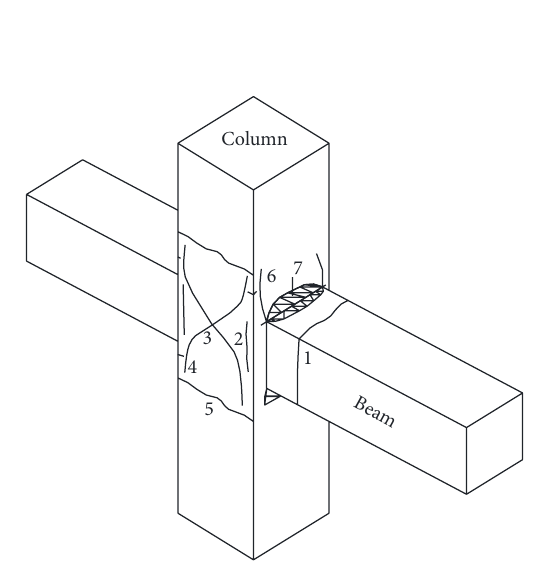
Figure 8: Typical crack